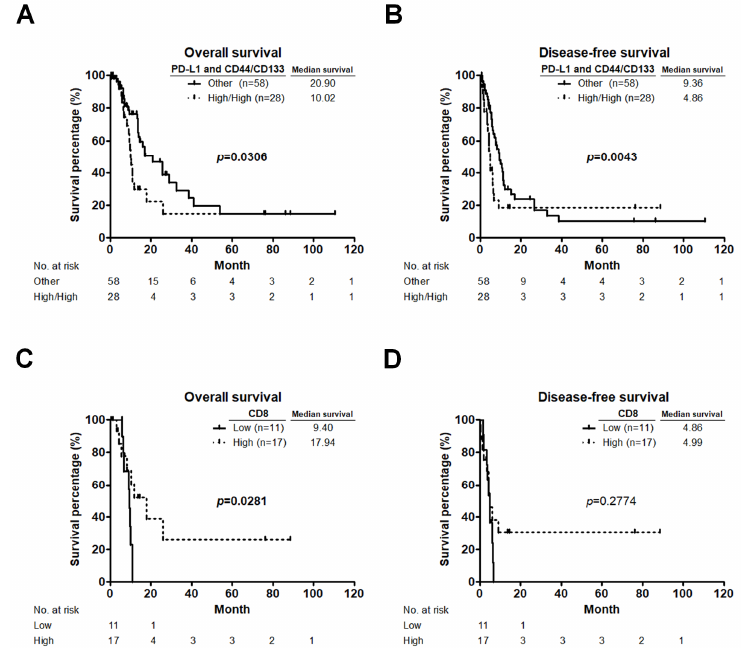
Figure 5. CD8 + T cells infiltration affects the prognostic value of co-expression of PD-L1 and CD44/CD133 in PC patients. ( A , B ) OS ( A ) and DFS ( B ) curves for patients with high co-expression of PD-L1 and CD44/CD133 compared to those with either low co-expression of PD-L1 and CD44/CD133, low PD-L1 expression and high CD44/CD133 expression, or high PD-L1 expression and low CD44/CD133 expression (other group). p values determined using the Gehan-Breslow-Wilcoxon test. ( C , D ) OS ( C ) and DFS ( D ) curves for patients with low and high CD8 + T cells infiltration based on high co-expression of PD-L1 and CD44/CD133. p values determined using the log-rank test. OS, overall survival; DFS, disease-free survival.